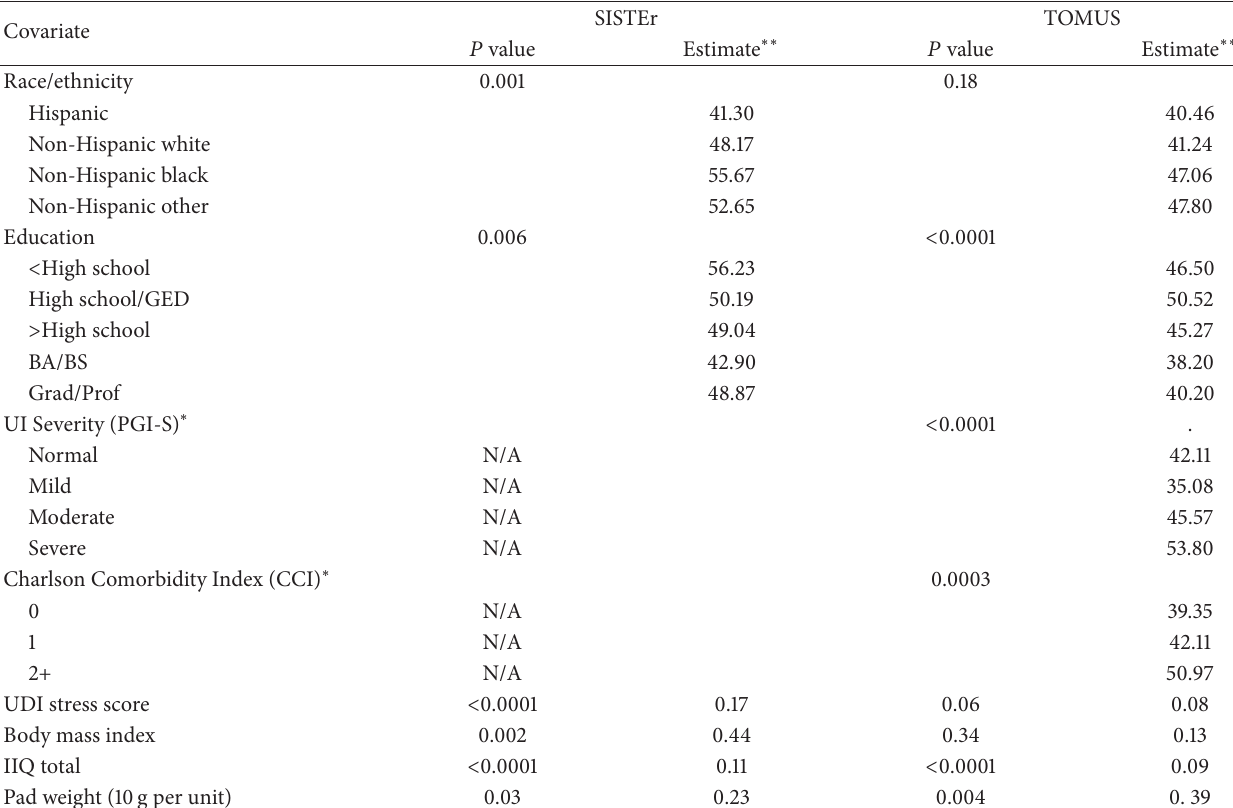
Table 2: Final multivariable linear regression models for the SISTEr and TOMUS trials with outcome of UDI-I.